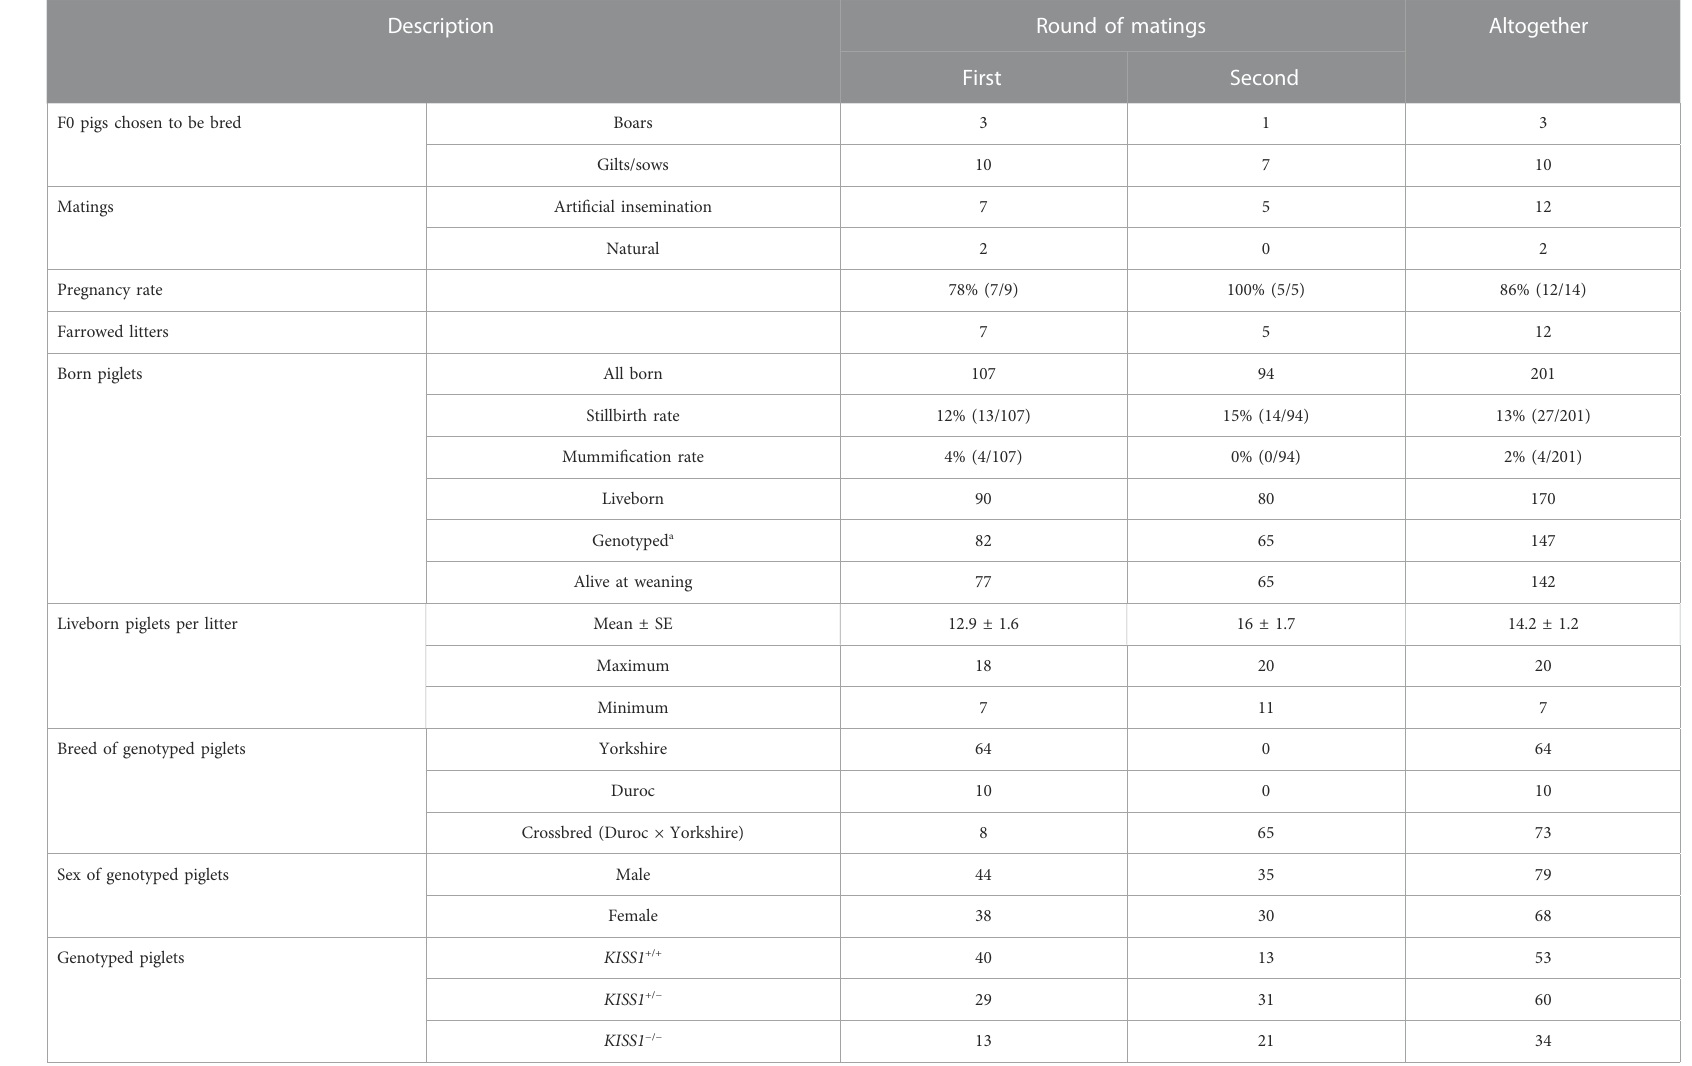
TABLE 2 Summary of the generation of F1 piglets harboring KISS1 -disrupted